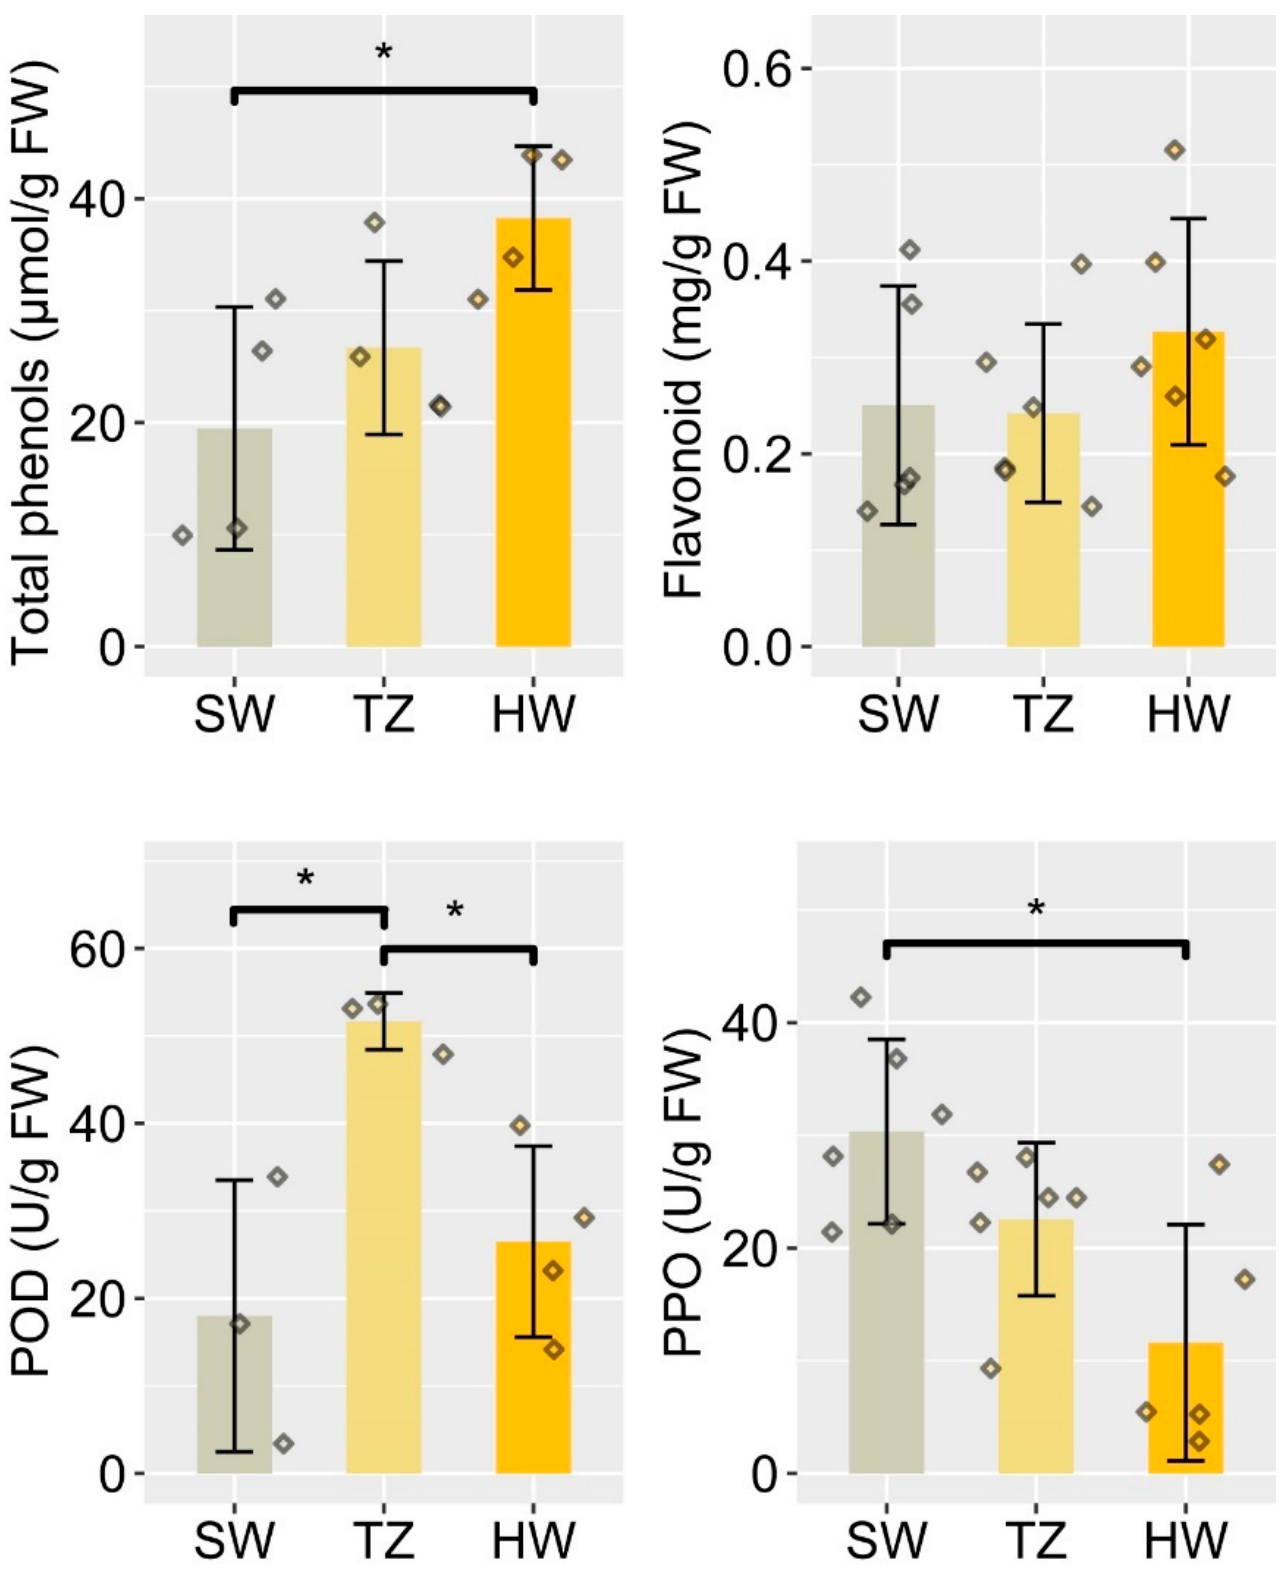
Figure 1. The contents of total phenols and flavonoids and the activities of POD and PPO in SW, TZ, and HW. * indicates a significant difference at the level of 0.05. The rhombus with different colors represented the biological replicates data of the contents of total phenols, flavonoids, and the activities of POD and PPO in different tissues.